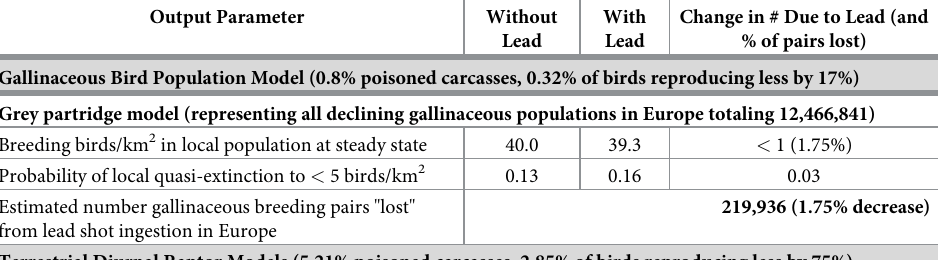
Table 3. Stochastic population modeling results for lead shot and bullet ingestion with effects on reproduction. Output Parameter Without With Change in # Due to Lead (and Lead Lead % of pairs lost) Gallinaceous Bird Population Model (0.8% poisoned carcasses, 0.32% of birds reproducing less by 17%) Grey partridge model (representing all declining gallinaceous populations in Europe totaling 12,466,841) Breeding birds/km 2 in local population at steady state 40.0 39.3 < 1 (1.75%) Probability of local quasi-extinction to < 5 birds/km 2 0.13 0.16 0.03 Estimated number gallinaceous breeding pairs "lost" 219,936 (1.75% decrease) from lead shot ingestion in Europe Terrestrial Diurnal Raptor Models (5.21% poisoned carcasses, 2.85% of birds reproducing less by 75%) Common Buzzard Model (representing stable and decreasing small-bodied populations in Europe totaling 404 , 006 –512,606) a Breeding pairs/10,000 km 2 in local population at final 1,656 1,624 32 (1.9%) steady state Probability of local quasi-extinction to < 350 breeding 0.010 0.019 0.009 pairs/10,000 km 2 in 50 years Red Kite Model (representing stable and decreasing small-bodied raptor populations in Europe totaling 404 , 006 –512,606) a Breeding pairs/10,000 km 2 in local population at final 1,693 1,595 97 (5.8%) steady state Probability of local quasi-extinction to < 350 breeding 0.00 0.00 0.00 pairs/10,000 km 2 in 50 years Red Kite Model (representing increasing small-bodied raptor populations in Europe totaling 53,868– 258 , 564 ) 1,331 1,183 148 (11.1%) Breeding pairs/10,000 km 2 in increasing local population (average of first 50 years) Probability of local quasi-extinction to < 350 breeding 0.0017 0.0064 0.0047 pairs/10,000 km 2 in 50 years Maximum population growth rate of breeding pairs 1.065 1.050 0.015 Bearded Vulture Model (representing stable and decreasing large-bodied raptor populations in Europe totaling 39,563) Breeding pairs/60,000 km 2 in local population at final 194 189 5 (2.7%) steady state Probability of local quasi-extinction to < 900 birds/ 0.002 0.004 0.002 60,000 km 2 in 50 years Bearded Vulture Model (representing increasing large-bodied raptor populations in Europe totaling 1,988) 190 184 6 (2.9%) Breeding pairs/60,000 km 2 in increasing local population (average of first 50 years) Probability of local quasi-extinction to < 900 birds/ 0.005 0.031 0.026 60,000 km 2 in 50 years Maximum population growth rate 1.080 1.076 0.004 Raptor Models Combined Estimated raptor breeding pairs/year lost from lead shot 45,380– 85 , 922 (4.1–7.7% decrease) and bullet ingestion in Europe